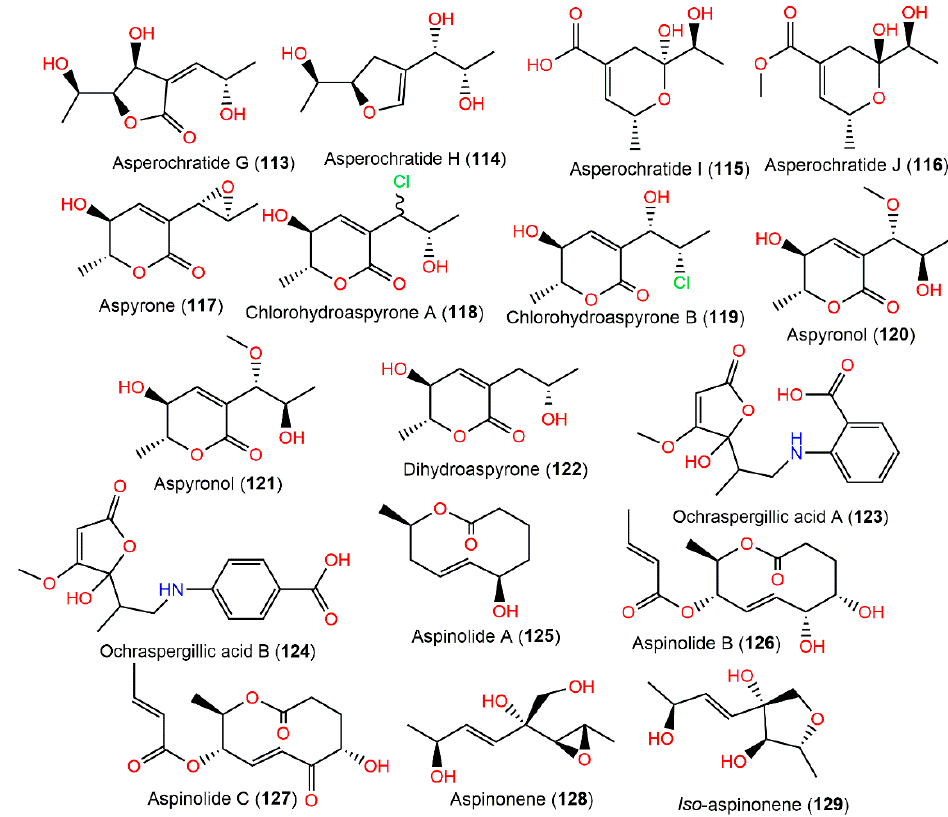
Figure 11. Polyketides ( 113 – 129 ) reported from A. ochraceus.